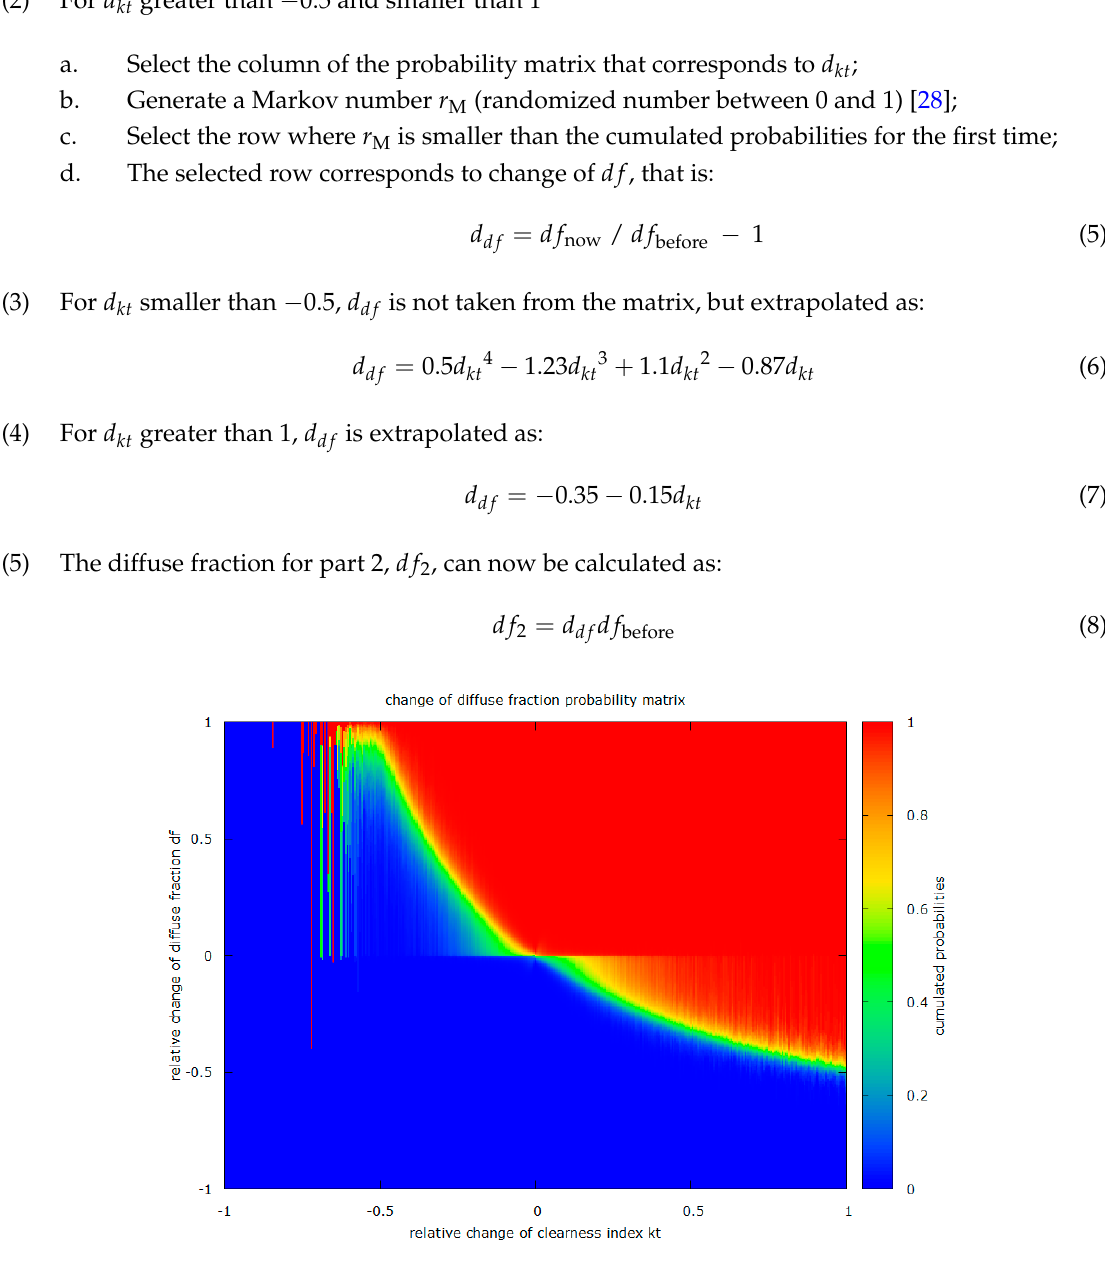
Figure 6. The same relation between changes of (cid:1856)(cid:1858) and changes of (cid:1863)(cid:1872) as in Figure 5, here as the probability matrix that is used in the model, corresponding to Figure 4. In the model, only relative (cid:1863)(cid:1872) changes of − 0.5 to 1 are computed with this matrix. In the matrix shown here, measurement values from the same locations and years as in Figure 4 were